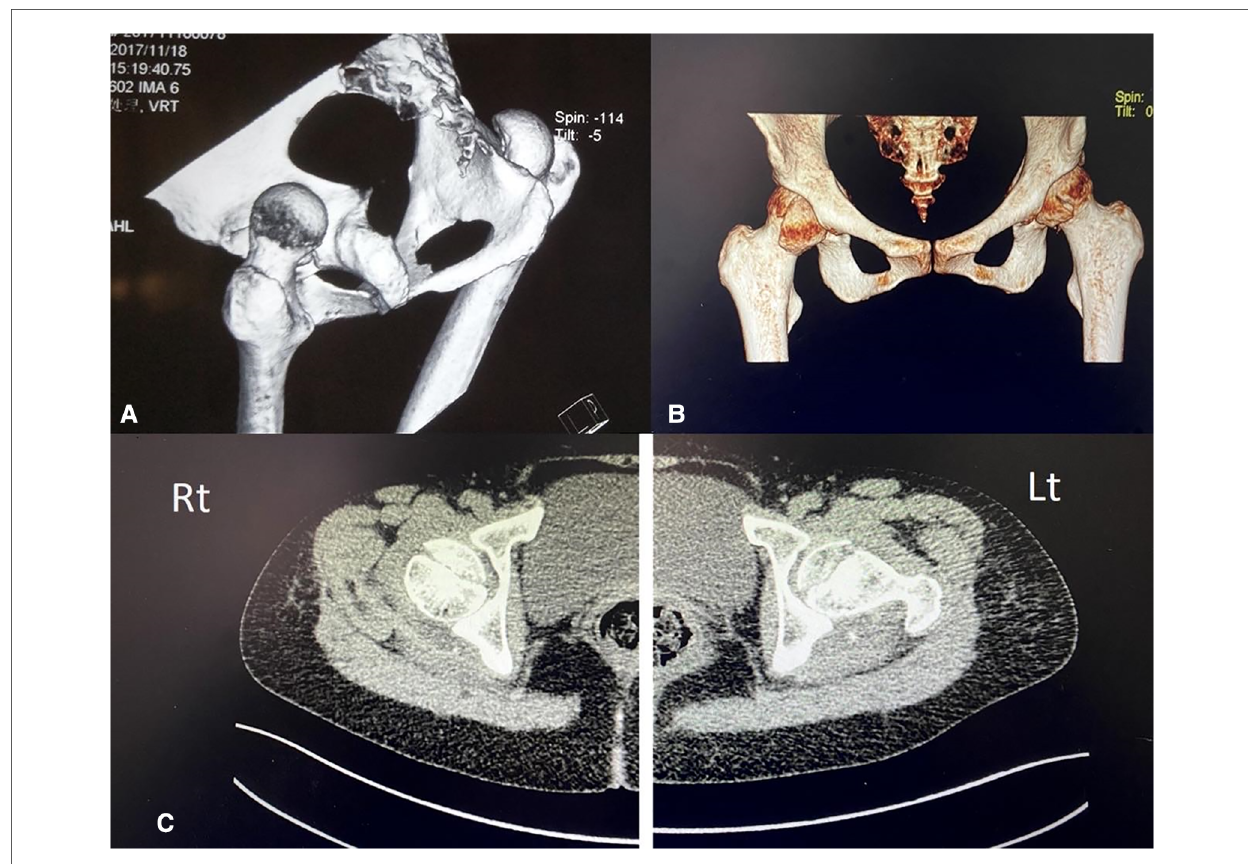
FIGURE 1 ( A ) 3D CT radiographs showing the bilateral posterior hip dislocation and femoral head fracture before the close reduction maneuver. ( B ) 3D CT radiographs showing bilateral relocated hip after reduction along with inferior part of femoral head fractures. ( C ) Plain CT transverse section of images showing bilateral intra-articular fractures of the femoral